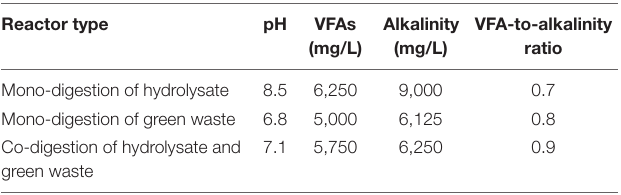
TABLE 3 | Process stability parameters during the continuous anaerobic digestion